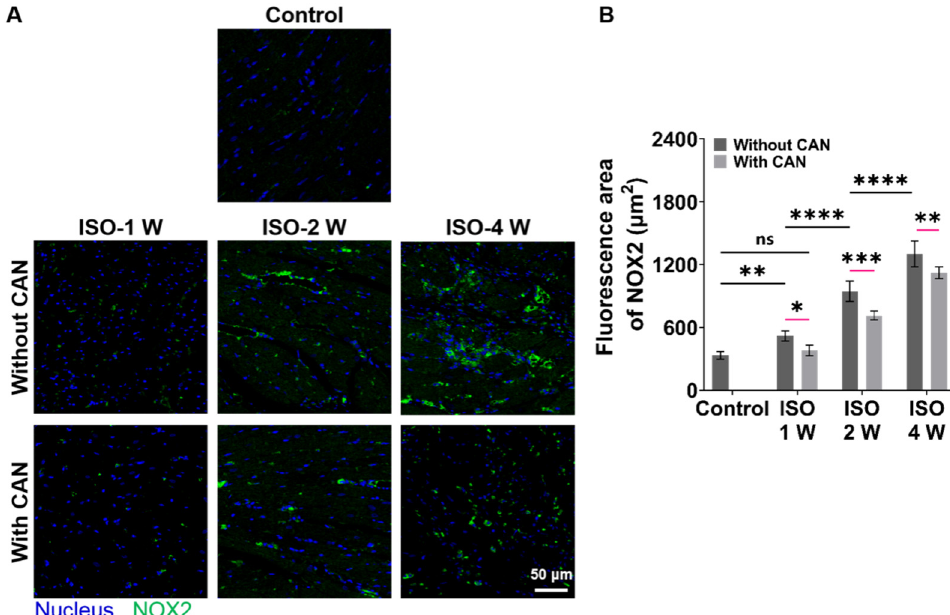
Figure 4. Characterization results of oxidative stress levels in myocardial fibrosis rats without and with CAN treatment. ( A ) NOX2 fluorescence images of fibrotic myocardium without and with CAN treatment. ( B ) Statistical histograms of fluorescence area of NOX2 of the fibrotic myocardium ( n = 5). Data are shown as means ± SEM. ns, no significant difference, * p < 0.05, ** p < 0.01, *** p < 0.001, and **** p < 0.0001 determined by two-way ANOVA.